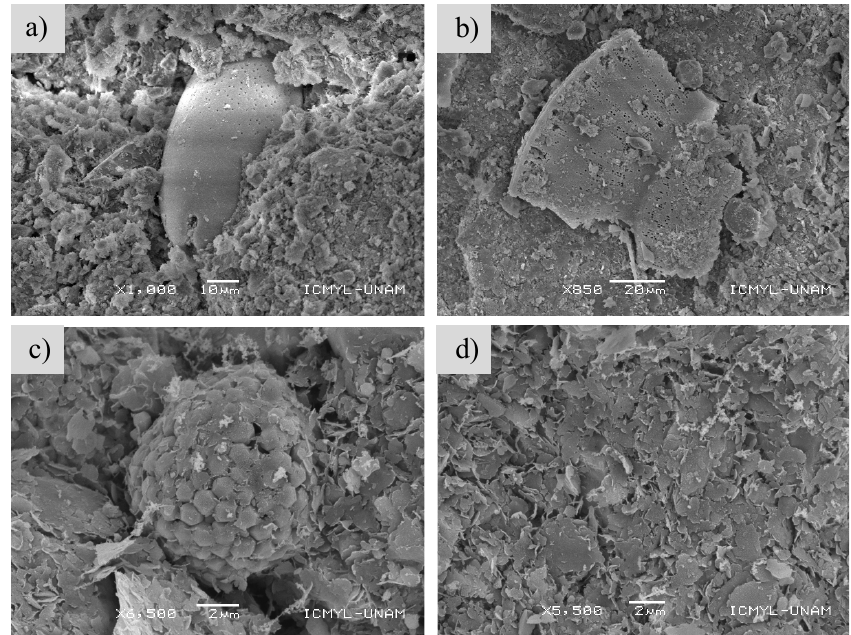
Figure 5. SEM micrographs of fine-grained samples (S07 and S11): ( a ) microscopic organism, ( b ) diatom frustule, ( c ) pyrite framboid, ( d ) dispersed clay microfabric.